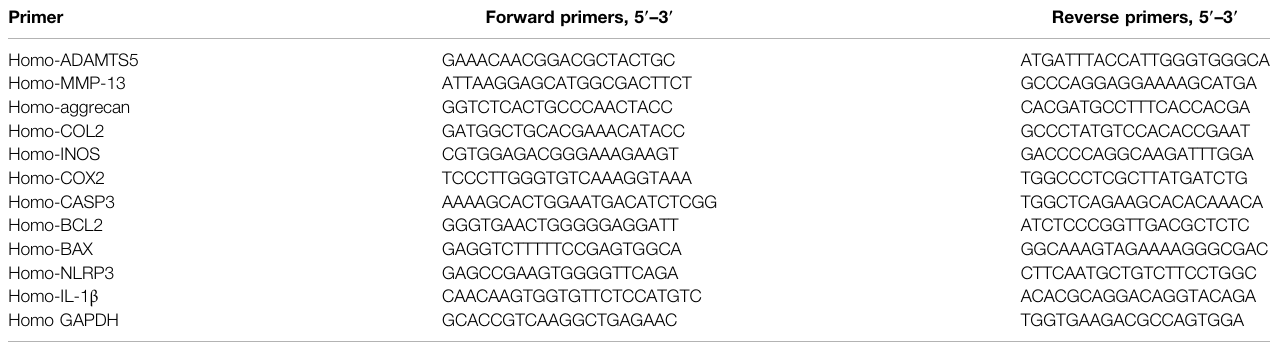
TABLE 1 | Primers used for quantitative real-time PCR.